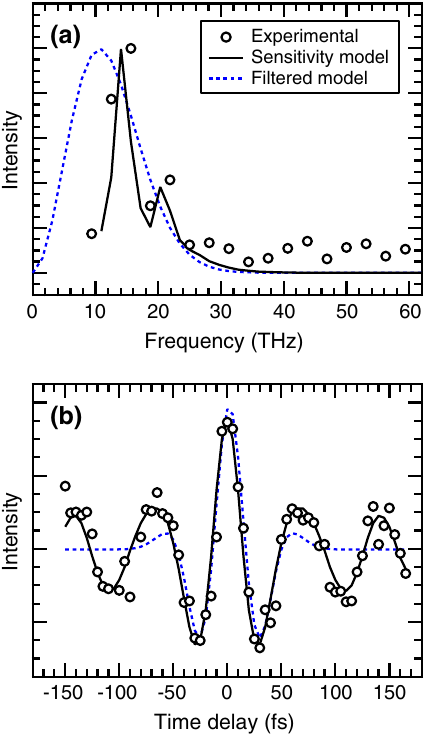
FIG. 6. (a) CTR frequency spectra of the experimental values (circles) and fitting curves from the filtered model (dashed line) and the sensitivity model (solid line). (b) Interferograms for each data set. Root-mean-square bunch lengths were determined to be 14 and 8.9 fs based on the least-squares fitting from the filtered model and the sensitivity model, respectively. All data was measured by the MCT